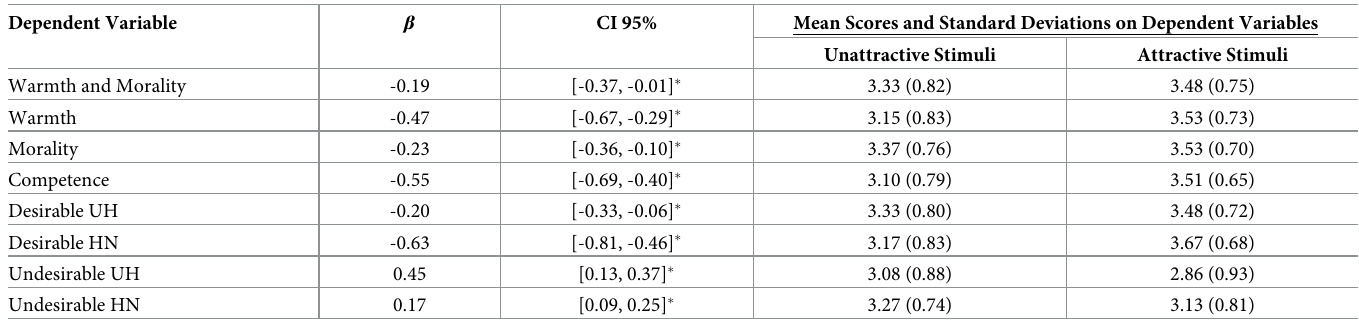
Table 2. The Effect of attractiveness on person